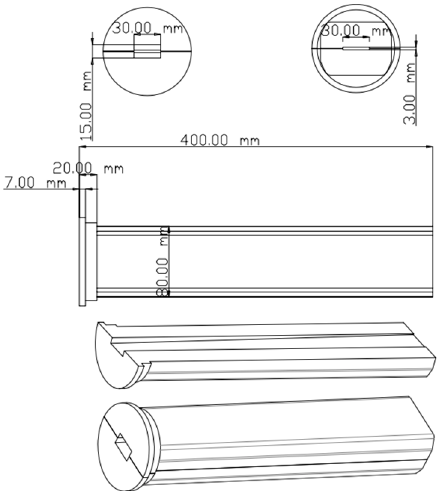
Figure 1. The shape and main dimensions of the long cooling